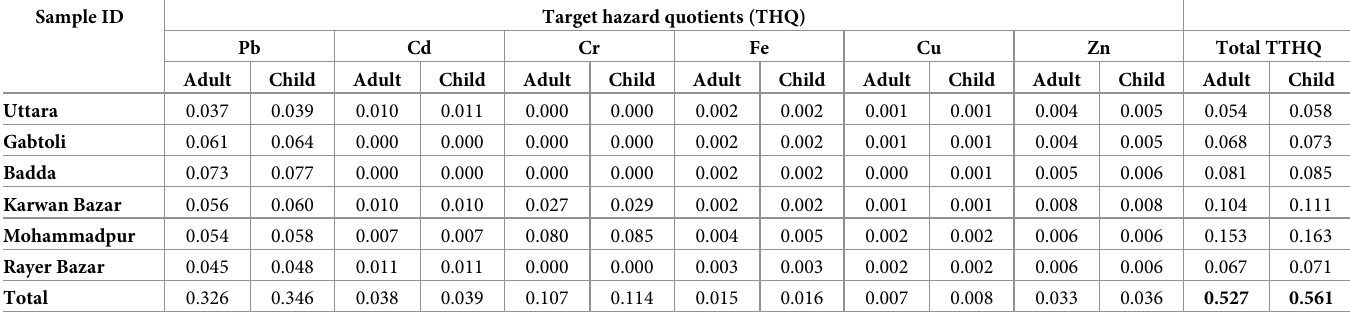
Table 6. Non-carcinogenic (THQ) health risks of heavy metals and trace elements due to consuming chicken meat from DNCC of Bangladesh. Sample